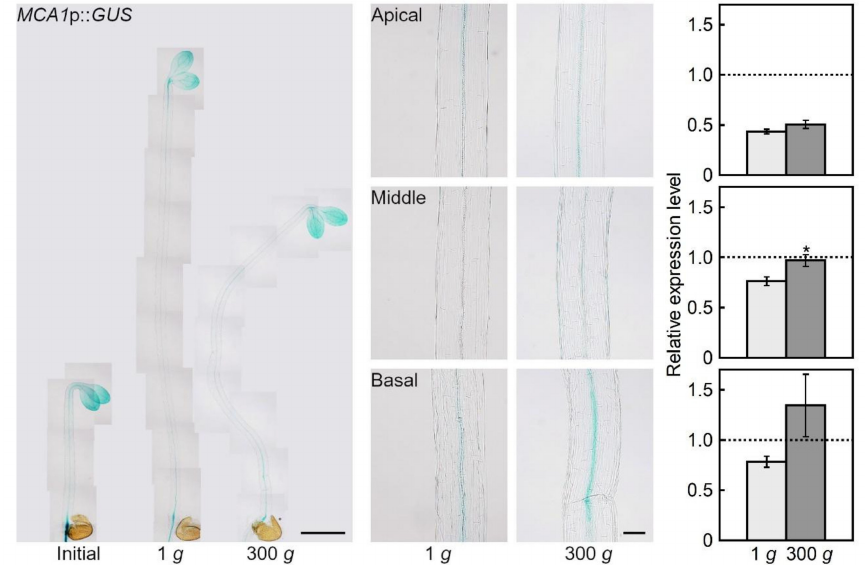
Figure 1. E ff ects of hypergravity on MCA1 gene expression. An MCA1 p:: GUS transgenic line was grown at 25 ◦ C for 48 h at 1 g . The seedlings were then transferred to 1 g or 300 g conditions and grown at 25 ◦ C for an additional 24 h. Left, GUS-stained seedlings (bar = 1 mm). Middle, magnification of the hypocotyls (bar = 0.1 mm). Right, quantified GUS-staining intensity (expression level) of each region of the hypocotyl. The expression level was normalized to the initial mean value. The dashed line indicates the initial values. Values are means ± SE ( n = 10–12). * Mean value with a significant di ff erence between the 1 g and 300 g treatments (Student’s t- test: p < 0.05).